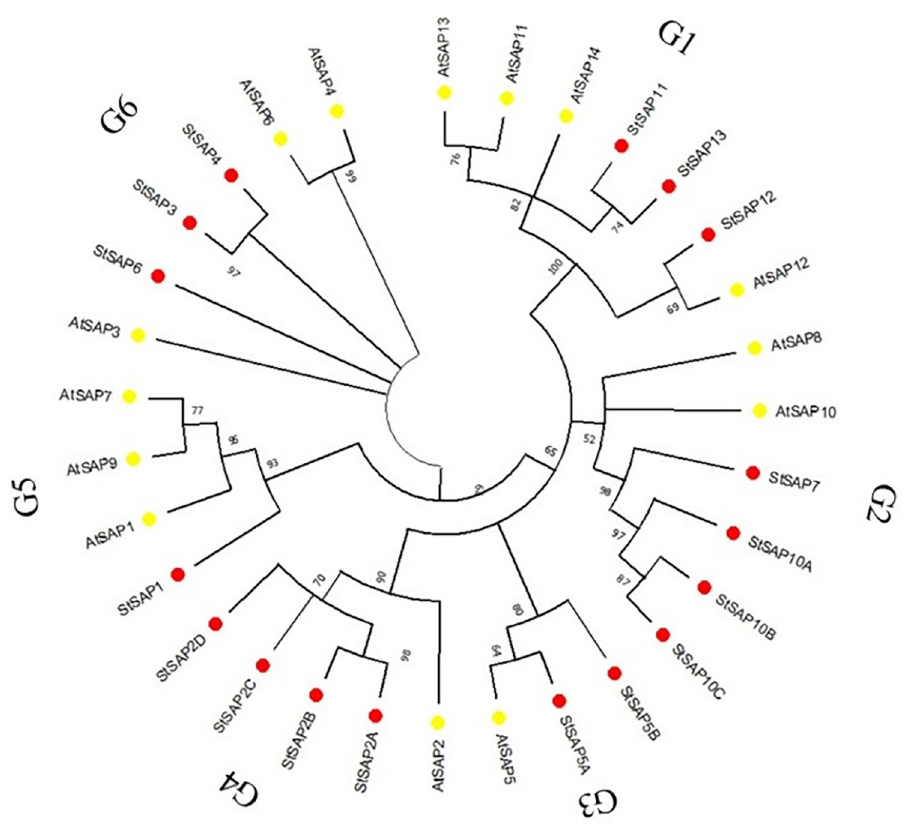
Fig 1. Phylogenetic tree showing SAPs in S . tuberosum (Red) and A . thaliana (Yellow).